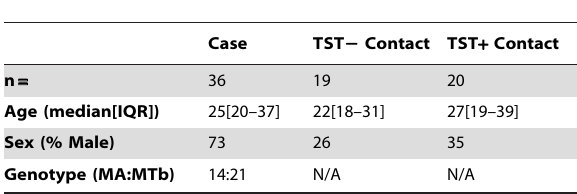
Table 2. Subject